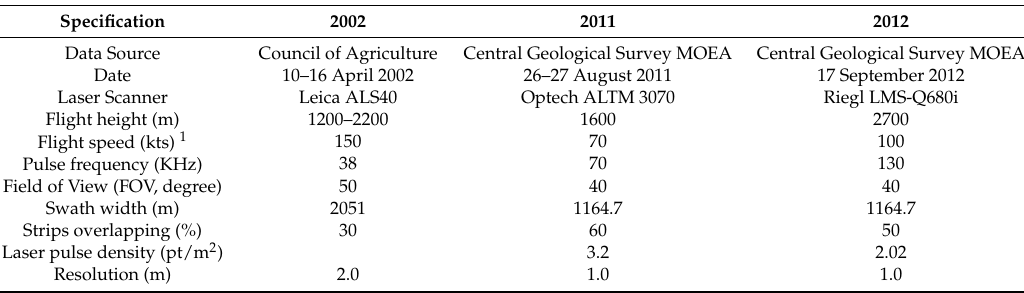
Table 1. Flight parameters of three periods of ALS data used in the